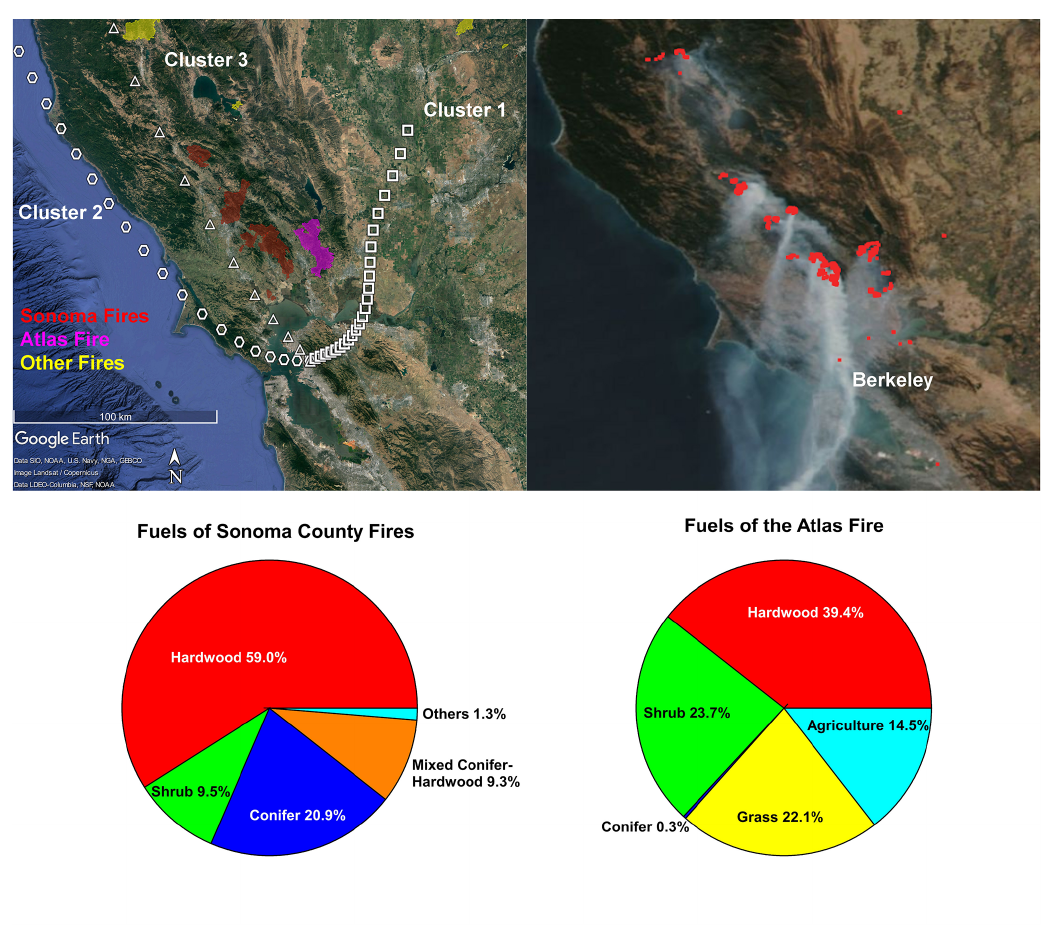
Figure 1. (a) Perimeters of fires and the mean backward trajectory of each cluster with one symbol per hour; (b) satellite image of this area on 12 October 2017, with fire points detected by VIIRS labeled by red dots; (c) fuel composition of the fires in the Sonoma County; (d) fuel composition of the Atlas Fire in Napa County. Map © Google Earth